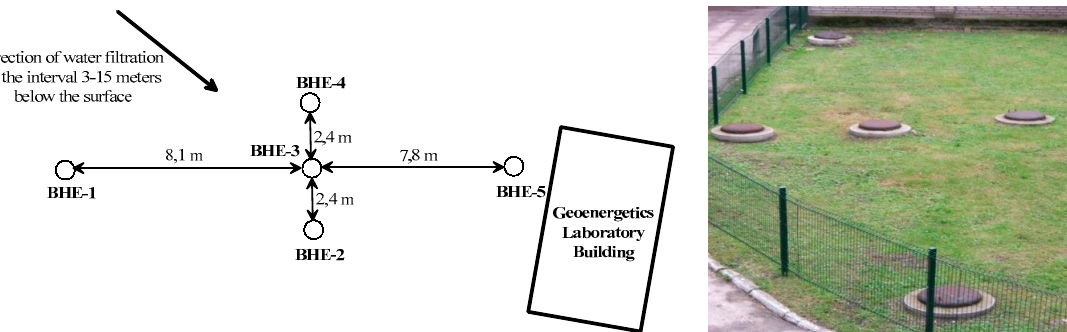
Figure 4. Layout of the borehole heat exchanger field in the Laboratory of Geoenergetics, Department of Drilling, Oil and Gas AGH UST. BHE-1 is a coaxial system, BHE-2, BHE-3, and BHE-4 are boreholes with a single U-pipe design and various sealing, BHE-5 has a double U-tube design [3].